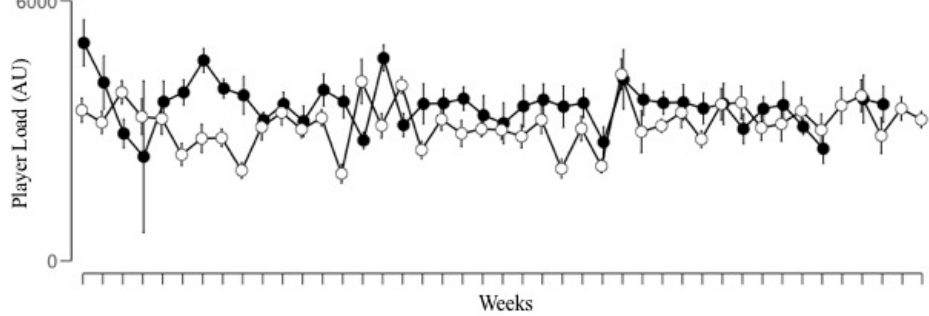
Figure 1. Distribution of the weekly accumulated PlayerLoad in arbitrary units (AU) for the seasons